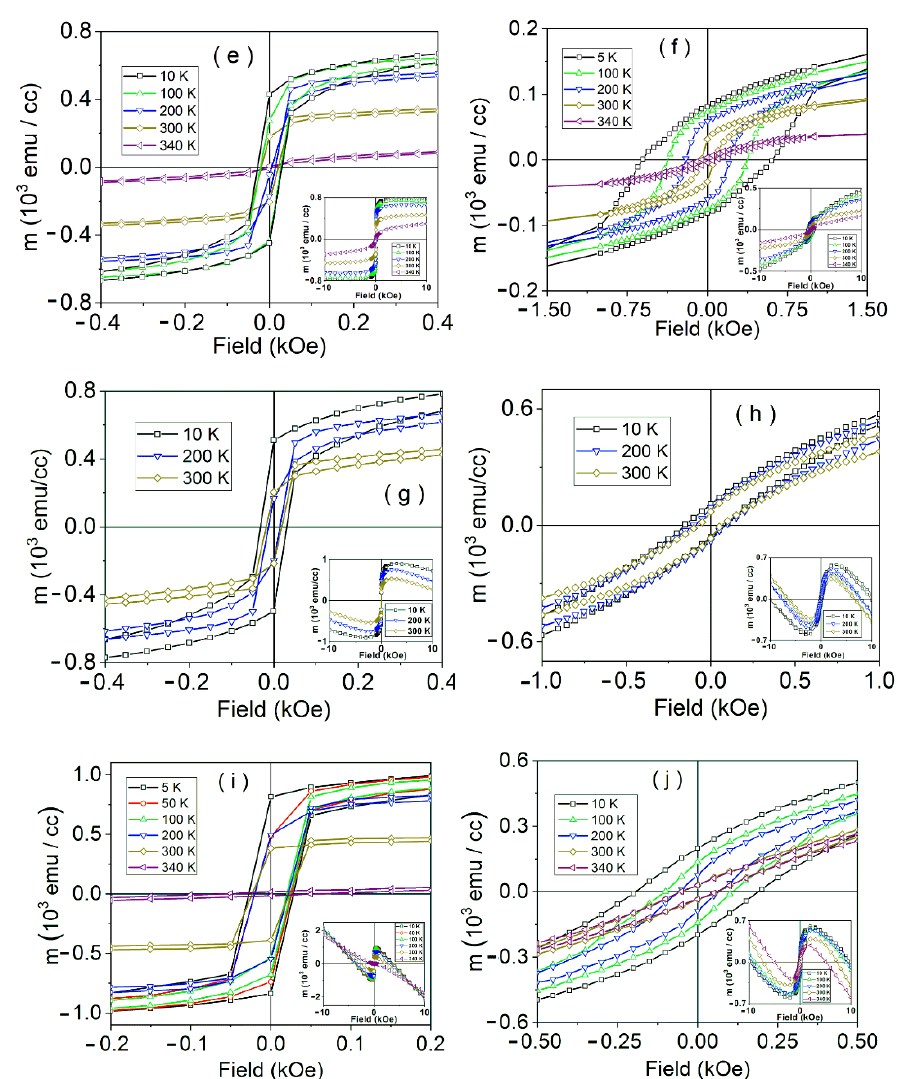
Figure 4. Magnetic hysteresis curves in the low field range of samples: LSMO 90 in parallel ( a ) and perpendicular ( b ) geometry; LSMO 60 in parallel ( c ) and perpendicular ( d ) geometry; LSMO 36 in parallel ( e ) and perpendicular ( f ) geometry; LSMO 30 in parallel ( g ) and perpendicular ( h ) geometry; LSMO 9 in parallel ( i ) and perpendicular ( j ) geometry. The corresponding raw curves in the high field range are shown as insets. The linear diamagnetic component due to the substrate was extracted in the main